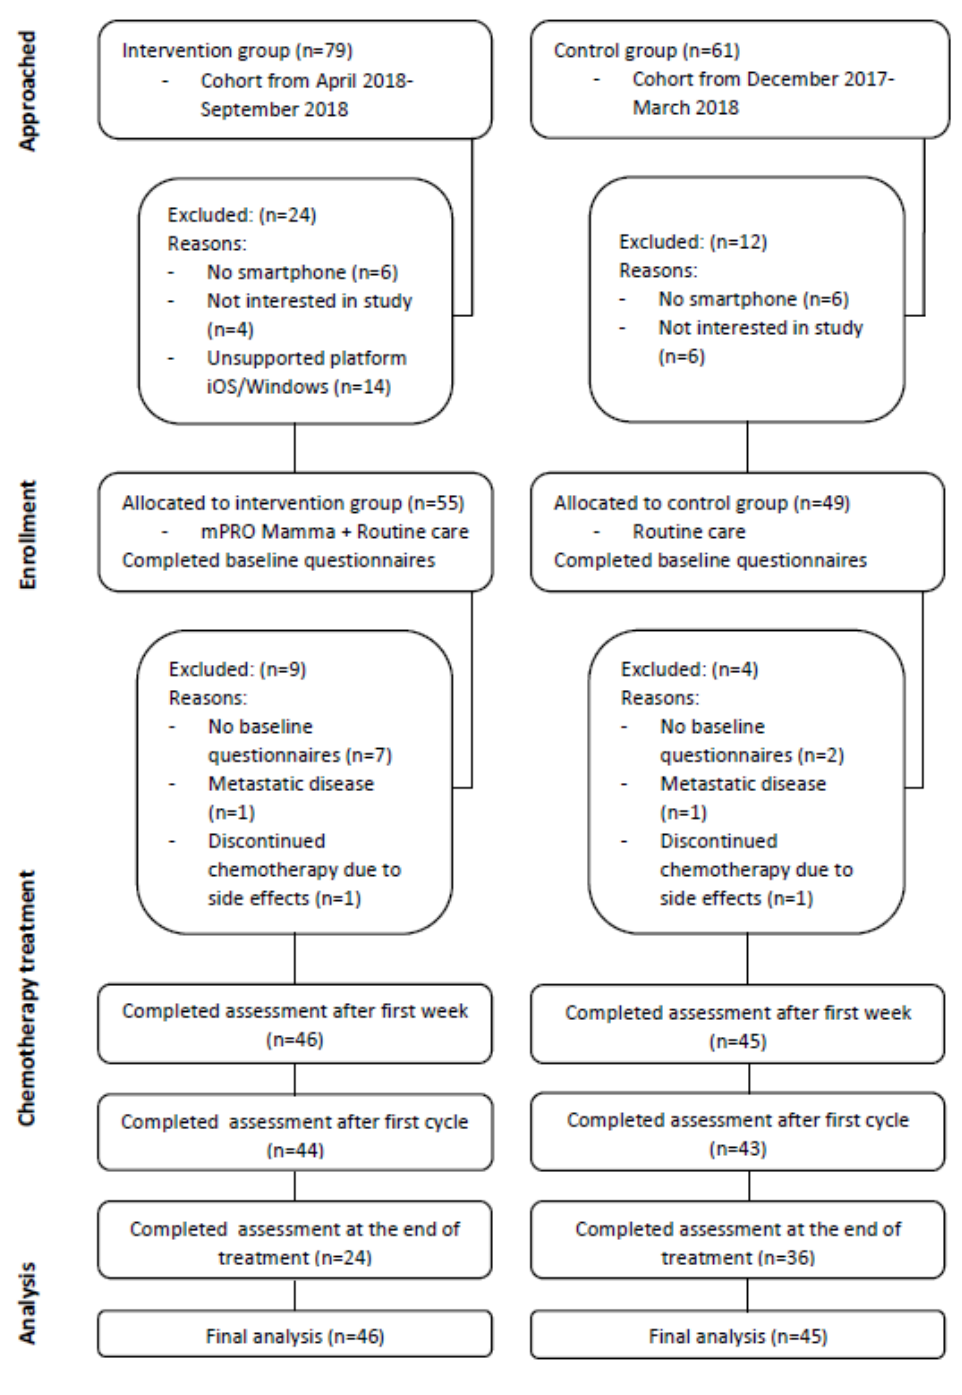
Figure 2. Consolidated Standard of Reporting Trials (CONSORT) diagram showing the flowchart of patients with breast cancer by group and reasons for exclusion from the study and the